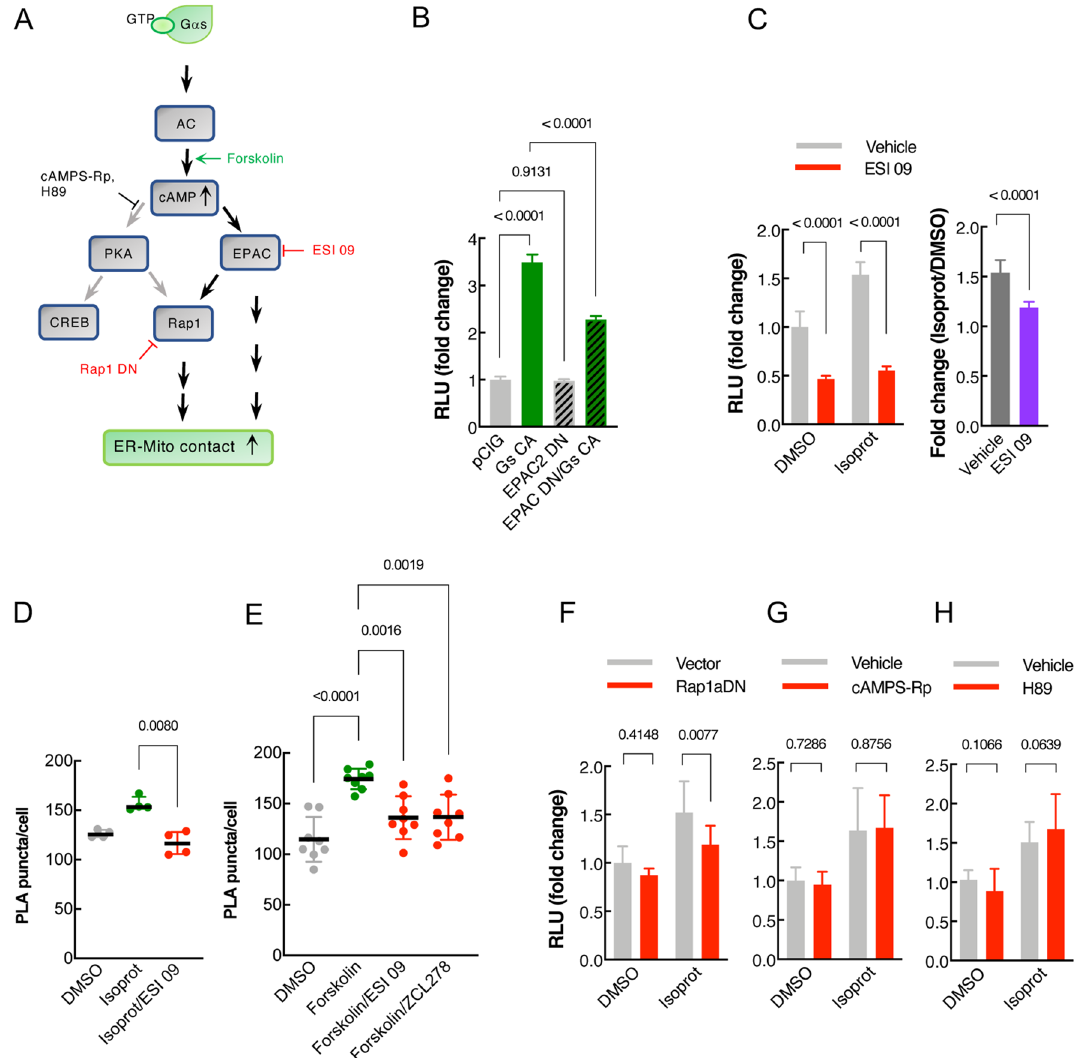
Figure 4. Gαs/cAMP pathway mediates β2-AR signal-induced ER-Mito contacts. ( A ) Schematic of the simplified G αs and G αi pathway. Arrows: downstream pathways involved (black) or not-involved (grey) in β2-AR-mediated contact modulation. Pathway inhibitors labeled with red (repressing) or black (not repressing) depending on their ability to repress agonist-induced contacts; activator (forskolin): green. ( B ) Split-Rluc assay in HEK293T transfected with pCIG (vector expressing GFP), G αs CA, EPAC DN, EPAC DN with G αs CA. n = 8; One-way ANOVA with Tukey’s multiple comparisons test. ( C ) (Left) Split-Rluc assay in H293T cells treated with vehicle vs ESI 09 (5 μM) in the presence of DMSO or isoprot. n = 8; 2-way ANOVA with Sidak’s multiple comparisons test. (Right) Fold change of isoproterenol-induced luciferase activity (isoprot/DMSO) in the presence of vehicle vs. ESI 09 (using the data sets from the left graph); two-tailed t -test. ( D , E ) Quantification of PLA in HeLa cells treated with DMSO, isoprot, or isoprot with ESI 09 ( D ) ( n = 4 with 64 (DMSO), 107 (isoprot), 70 (Isoprot/ESI 09) cells each; Kruskal Wallis test with Dunn’s multiple comparisons test), or with DMSO, forskolin, forskolin with ESI 09, or forskolin with ZCL 278 ( n = 8 with 117–167 cells each; one-way ANOVA test with Sidak’s multiple comparisons test). ( F–H ) S plit-Rluc assay in HEK293T cells transfected with vector or Rap1a DN ( G , n = 8), or treated with vehicle or PKA inhibitors cAMPS-Rp (10 μM; n = 20) ( H ) and H89 (10 μM; n = 15) ( I ), in the presence of DMSO or isoprot; 2-way ANOVA with Sidak’s multiple comparisons test. All data except in D and F: mean ± SD; data in ( D , F ): median with interquartile between the vehicle- vs. ESI 09- treated cells and found a statistically significant difference (1.54 ± 0.128, vehicle; 1.19 ± 0.057, ESI 09; p < 0.0001) (Fig. 4C, right). Together with EPAC DN data, these results confirm the require- ment of the EPAC for the isoproterenol-induced contacts, although ESI-09 appears to affect basal level contacts as well. Corroborating these results, the PLA in HeLa cells also demonstrated a similar inhibitory effect of ESI 09 (Fig. 4D). Consistent with these data, ESI 09 also blocked forskolin-induced PLA signal enhancement (forskolin increases cAMP by stimulating adenylyl cyclase) (Fig. 4E). Of note, we found that RAP1A (EPAC downstream effector) is also involved, as RAP1A DN decreased the isoproterenol response (Fig. 4F), albeit its effect is not